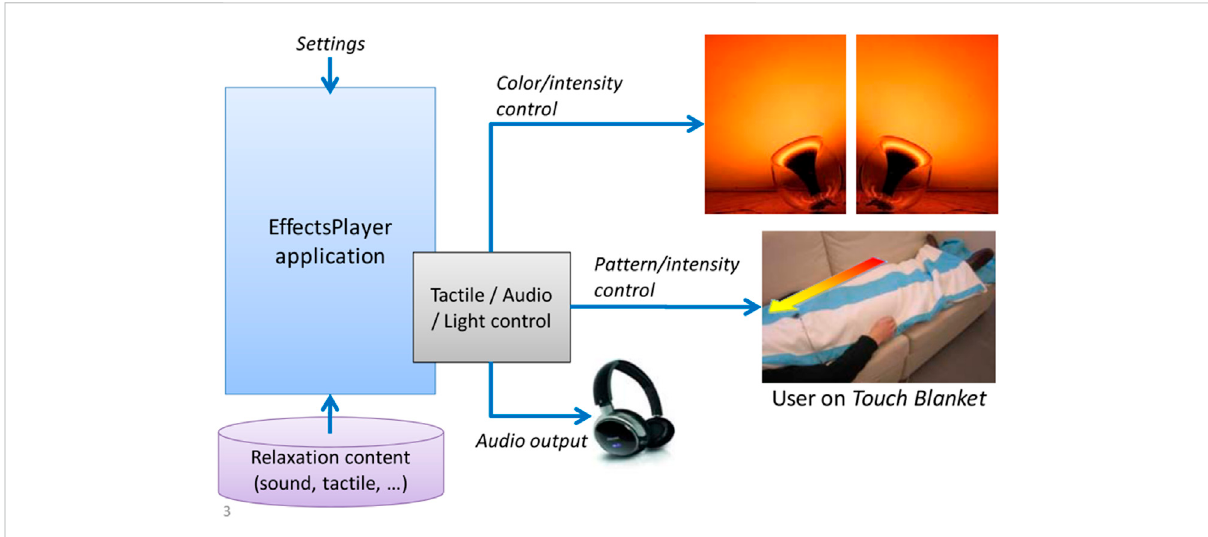
Simpli fi ed system diagram of open-loop audio – tactile breathing guide, providing tactile stimuli via the Touch Blanket and audio/light stimuli (reproduced from Dijk and Weffers